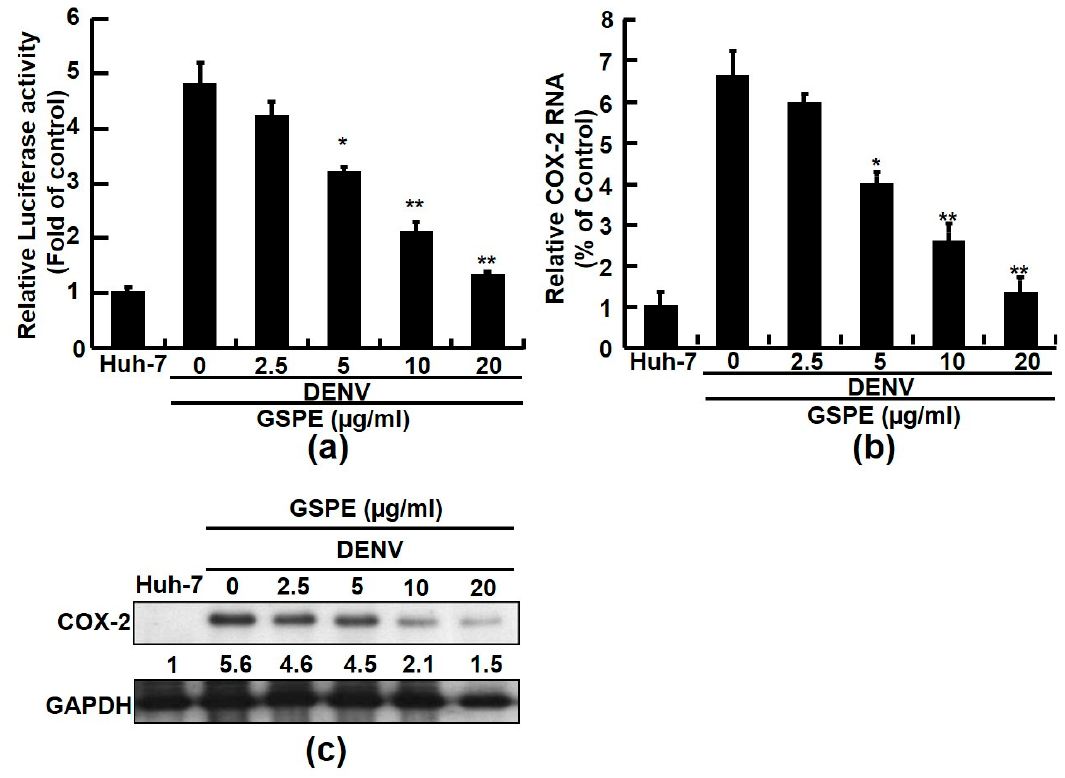
Figure 2. GSPE reduces DENV-induced COX-2 expression. ( a ) The GSPE treatment reduced COX-2 promoter activity in a concentration-dependent manner. Huh-7 cells were transfected with the pCOX-2-Luc reporter plasmid. After 8 h of transfection, the transfected-Huh-7 cells were infected with DENV-2 at an MOI of 0.1 for 2 h and treated with the indicated concentrations (2.5–20 µg/mL)